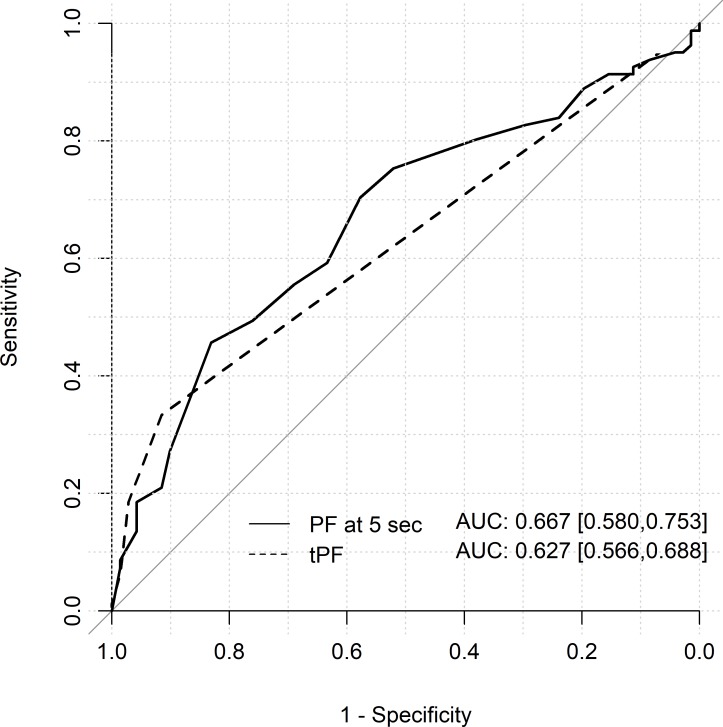
ROC curves for Peak Flow at 5 seconds and Time-to-peak flow in patients with severe aortic stenosis (AS).The curves show the predictive potential of PF at 5 seconds (solid line) and tPF (dashed line) variables with respect to PAD in patients with AS. PF at 5 seconds correlated well with ABPI; the tPF correlate less with ABPI in this group.